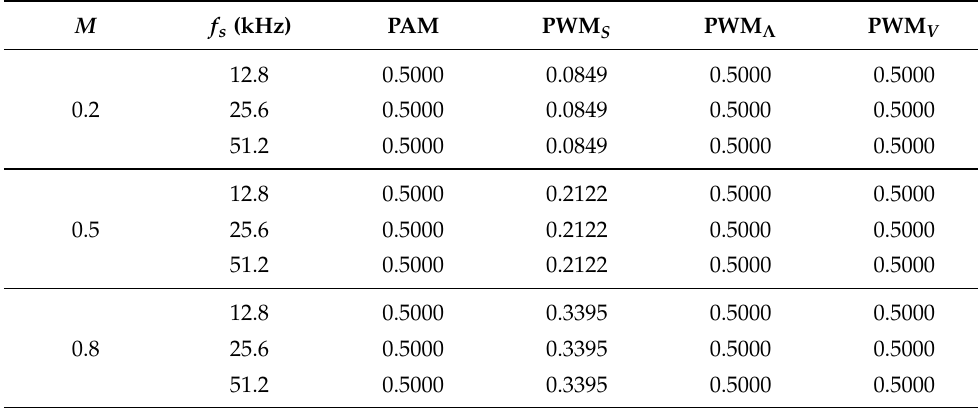
Table 1. Values of the relative delay γ as functions of M and f s